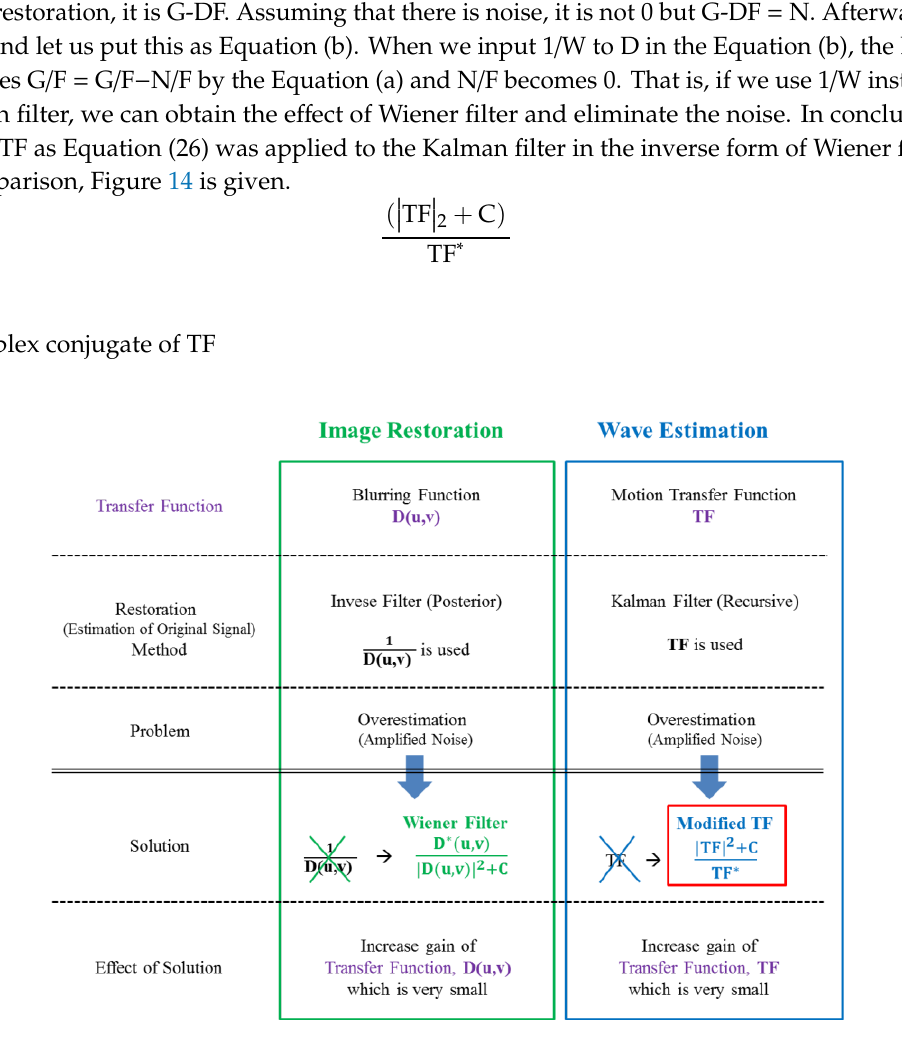
Figure 14. Comparison of Image Restoration and Wave Estimation.